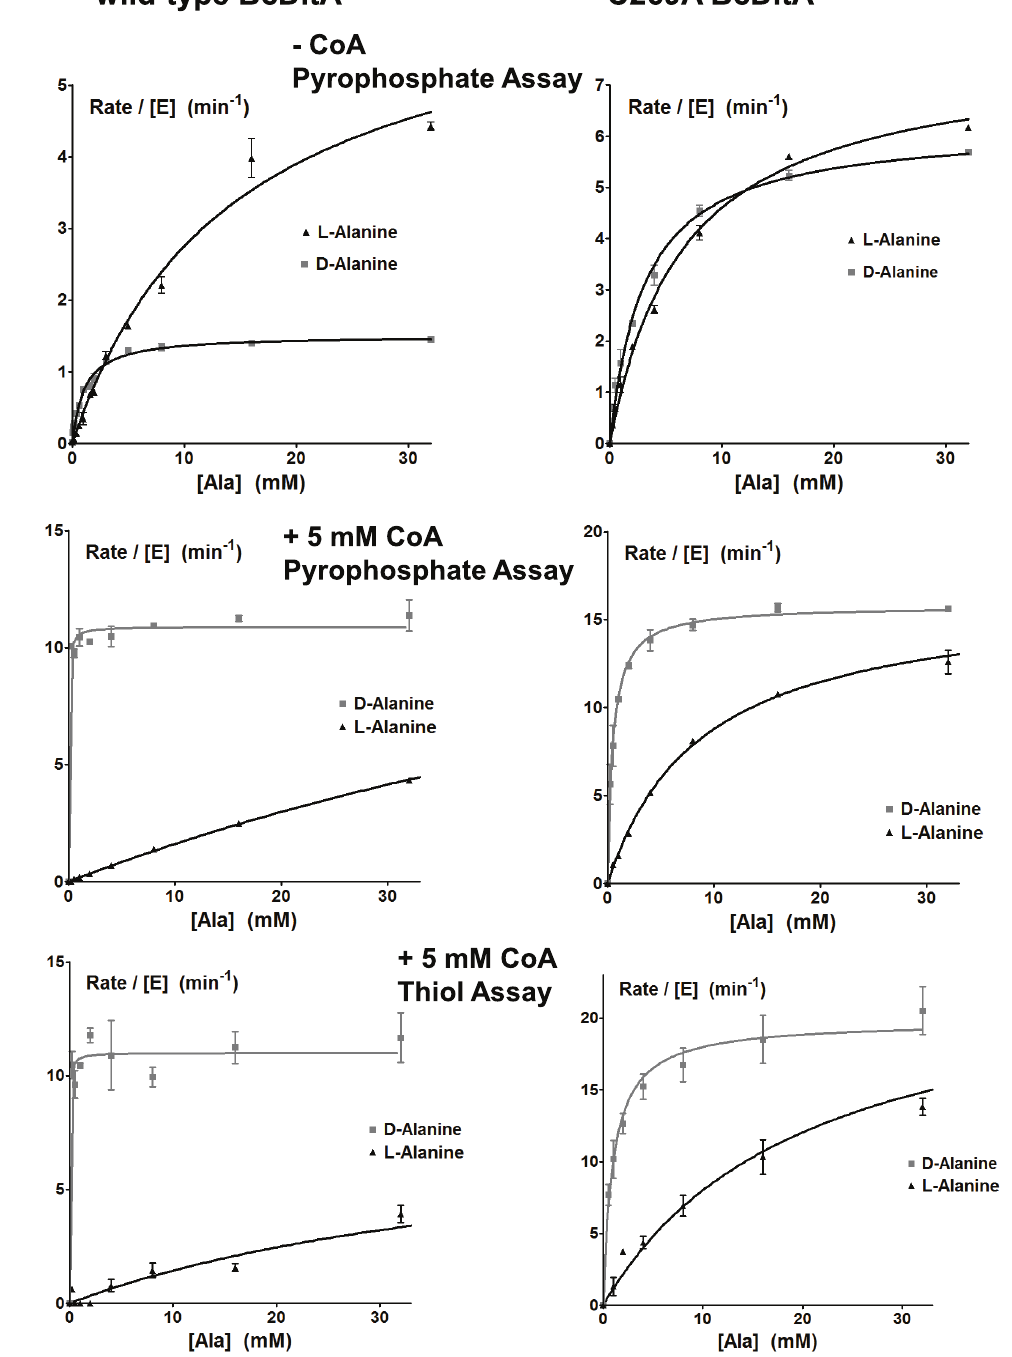
Figure 4. Rate of pyrophosphate release and thiol depletion. The reaction solutions contained 0.005 mM wild-type BcDltA, 5 mM D-alanine, 0.1 M KCl, 0.01 M MgCl , 0.05 M Hepes-NaOH buffer at pH 7.2, 5 unit/mL of yeast inorganic pyrophosphatase and specified concentrations 2 of ATP, alanine and CoA. Reaction rates for wild-type BcDltA are shown on the left, and those for the C269A mutant protein are shown on the right. The reaction rates in the absence of CoA are taken from a previous study 17